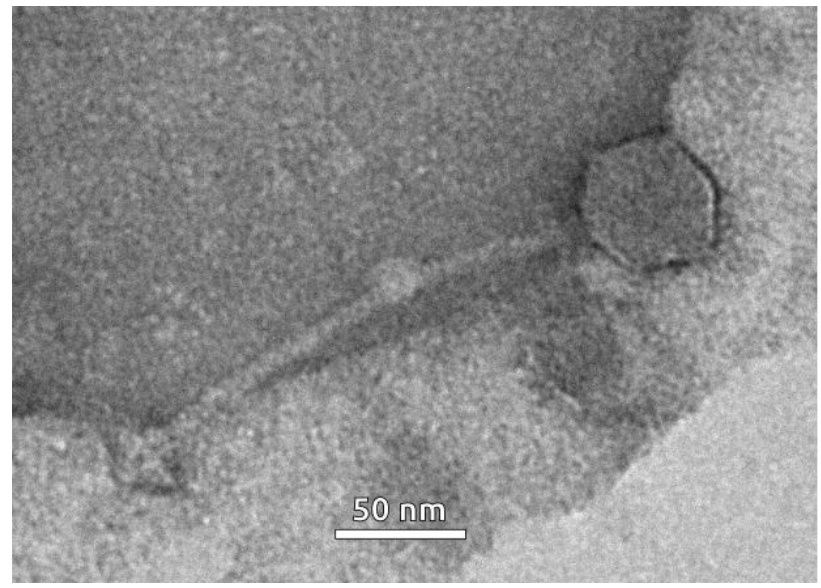
Figure 6. Electron microscopy image of phage particle induced by mitomycin C from the bacterial culture of Curtobacterium sp. VKM Ac-2884. The scale bar is 50 nm.